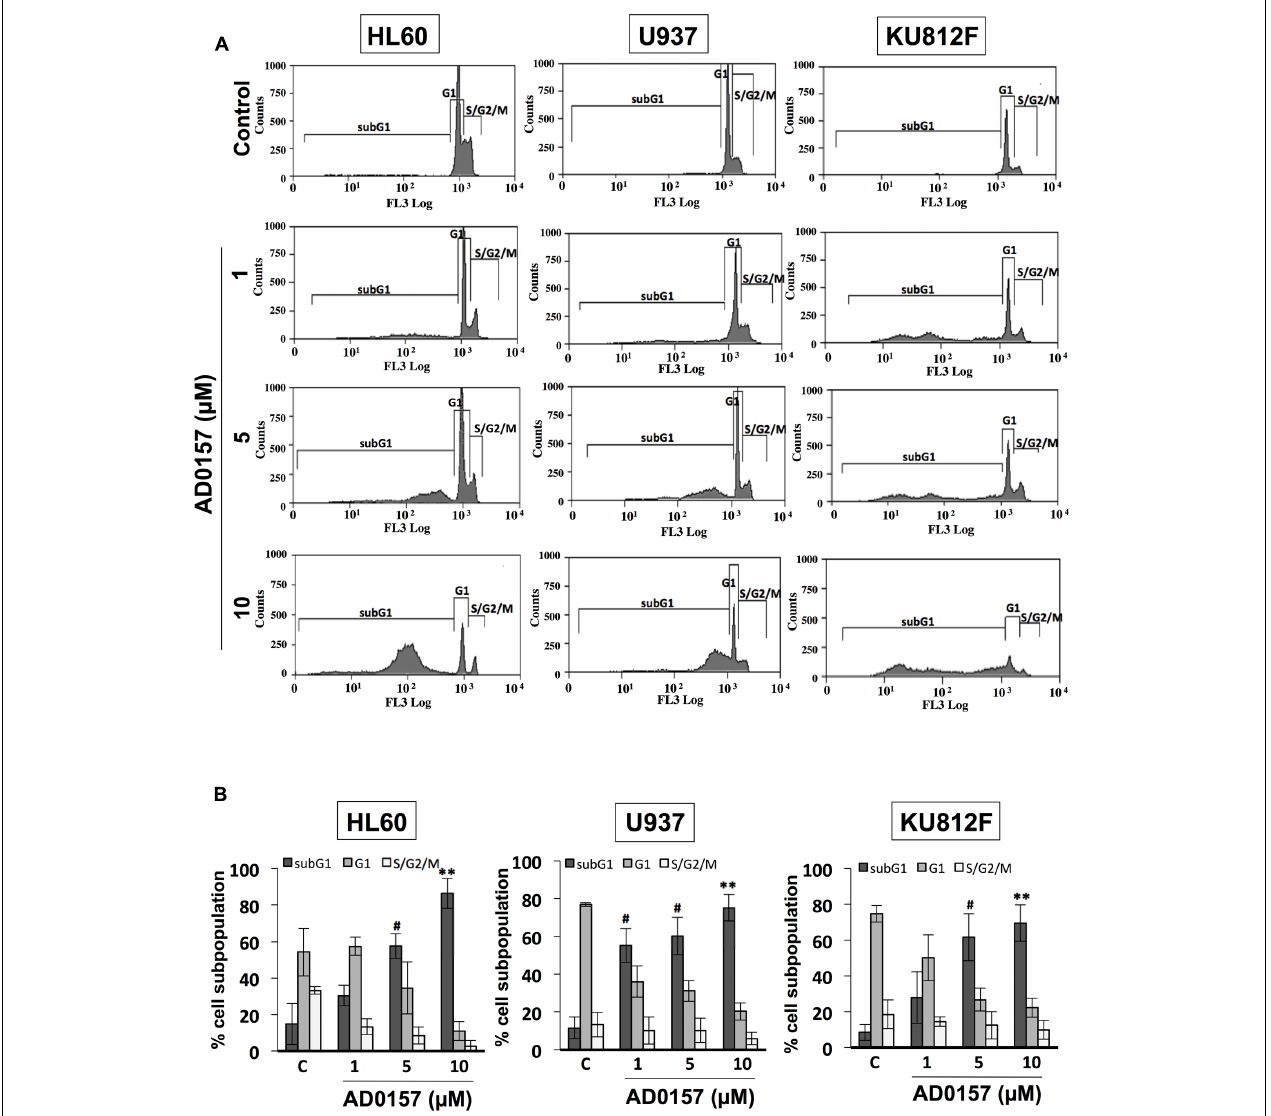
FIGURE 3 | AD0157 induces increases in the subG1 population of myeloid leukemia cells. (A) Representative flow cytometry histograms showing the effect of AD017 on HL60, U937 and KU812F cell cycle distribution. Leukemia cells were exposed for 14 h to AD0157 at the indicated concentrations, stained with propidium iodide and percentages of subG1, G1, and S/G2/M cells were determined using a MoFlo DakoCytomation cytometer. (B) Graphs correspond to the distribution of cell subpopulation percentages expressed as means ± SD of three independent experiments. # p < 0.005 and ∗∗ p < 0.001 versus untreated